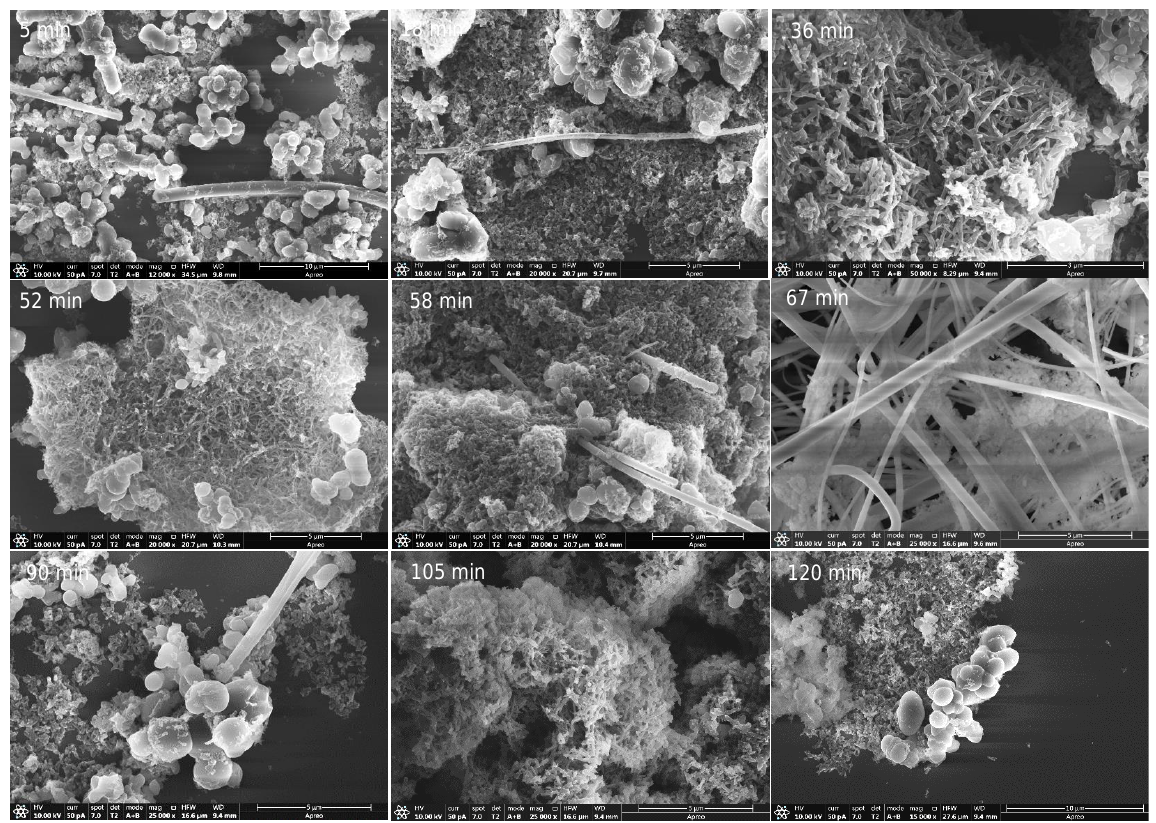
Figure 10. SEM images for representative samples from NH 4 CN polymers synthetized at 170 °C. Note the variation of the morphology with the reaction time indicated in each picture. Table 2. Qualitative summary for the observed shapes based on the SEM images from the NH 4 CN polymers synthetized at 170 ◦ C (please see the images collected in the supplementary information). – = not detected; + = detected but very minority and poorly representative; ++ and +++ = observed; ++++ = main shape